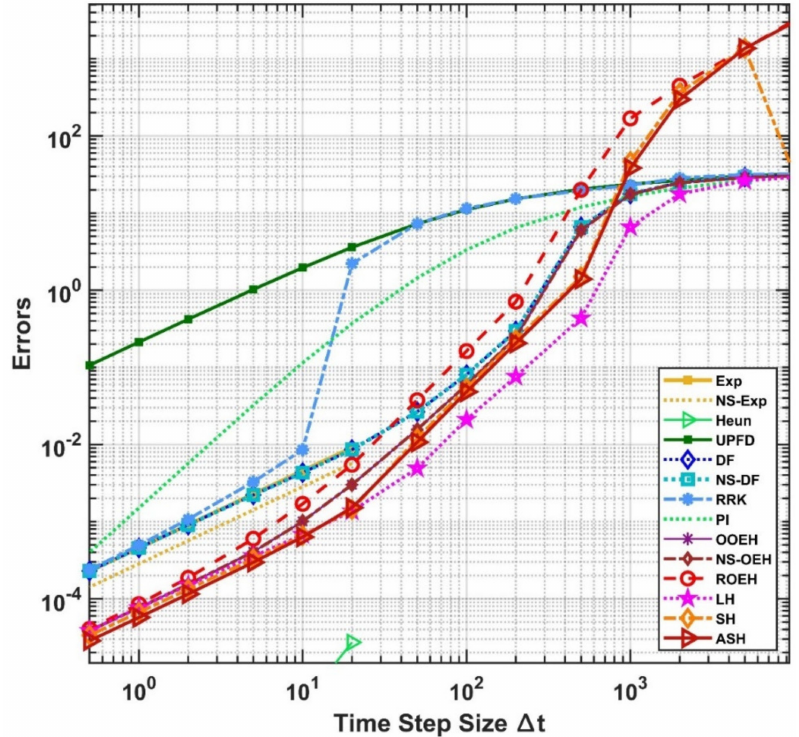
Figure 10. The maximum errors as a function of the time step size for the non-equidistant mesh.